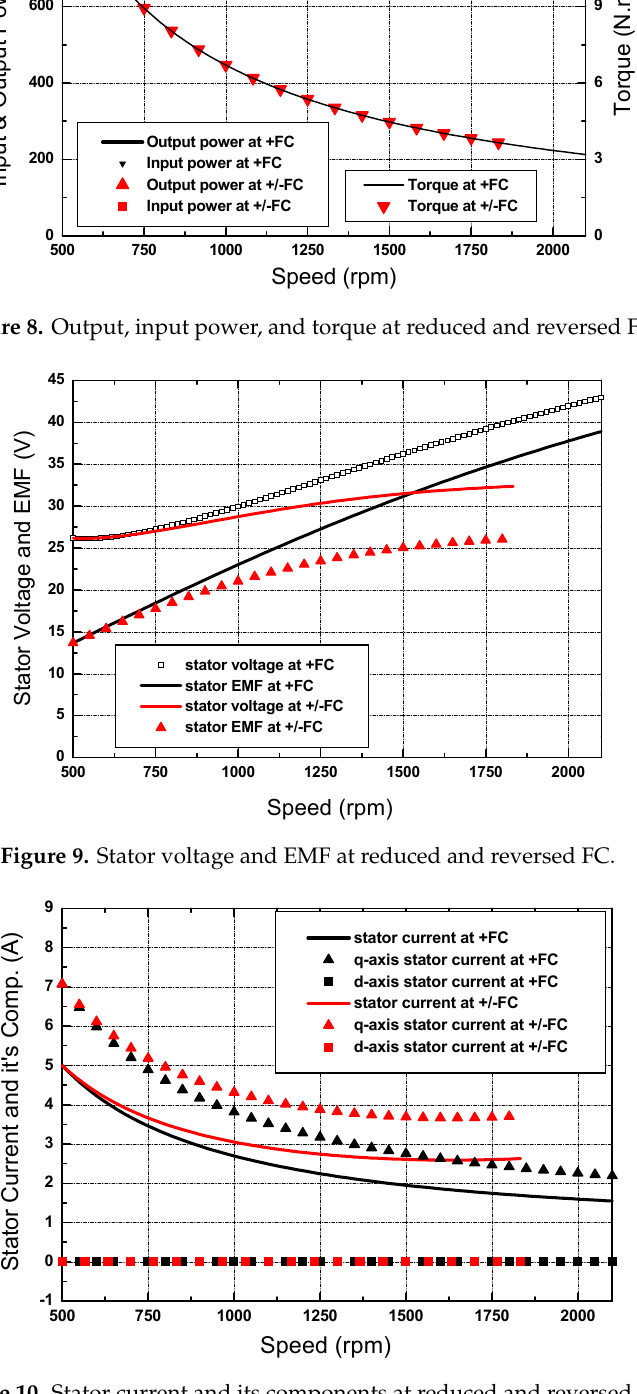
Figure 10. Stator current and its components at reduced and reversed FC.